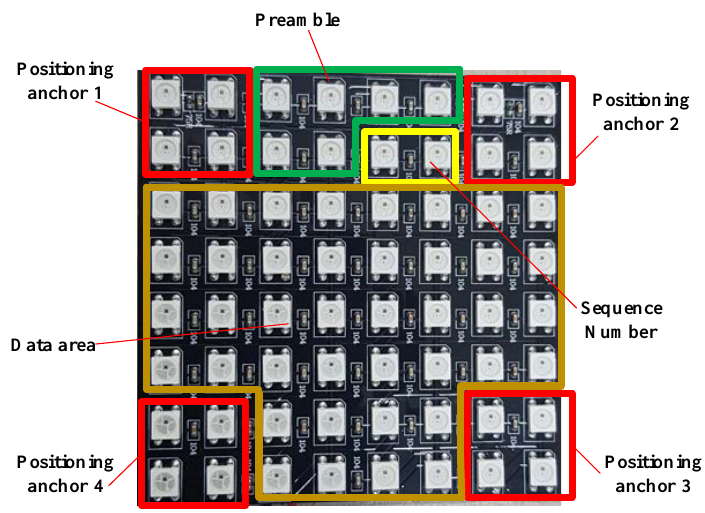
Figure 12. The spatial frame format in an LED array.